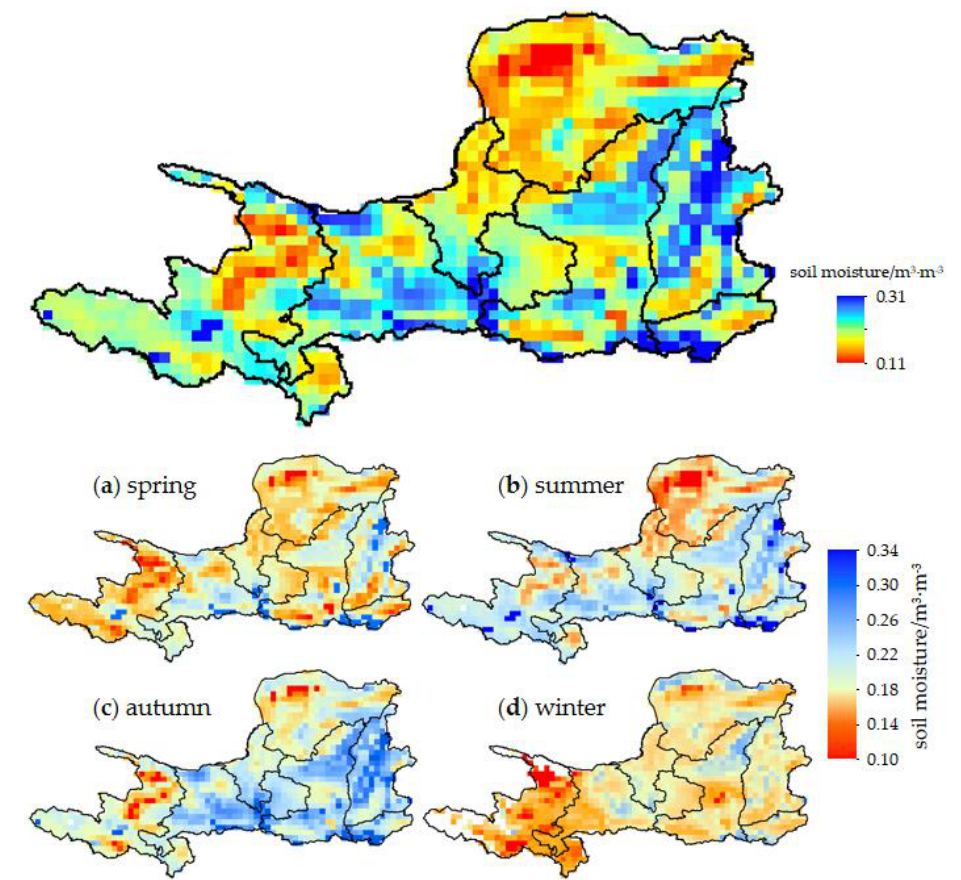
Figure 2. Spatial distribution of annual average SM and seasonal SM in the YRB from 2000 to 2015: ( a ) spring, ( b ) summer, ( c ) autumn, and ( d ) winter. From the seasonal distribution characteristics of SM, the SM in spring was relatively low, from 0.10 to 0.29 m 3 · m − 3 , and the regions with low values were the northeast and west of the upper reaches of the basin and the center of the middle reaches of the basin. In summer, the SM was relatively high, ranging from 0.10 to 0.34 m 3 · m − 3 , and the low value was mainly concentrated in the northeast of the upper reaches of the basin. In autumn, the SM in the basin was relatively high on the whole, ranging from 0.10 to 0.34 m 3 · m − 3 , with only very few low areas. The winter season is affected by seasonal snow and permafrost, resulting in some null values in the ESA CCI SM data. The overall SM of the basin was low,